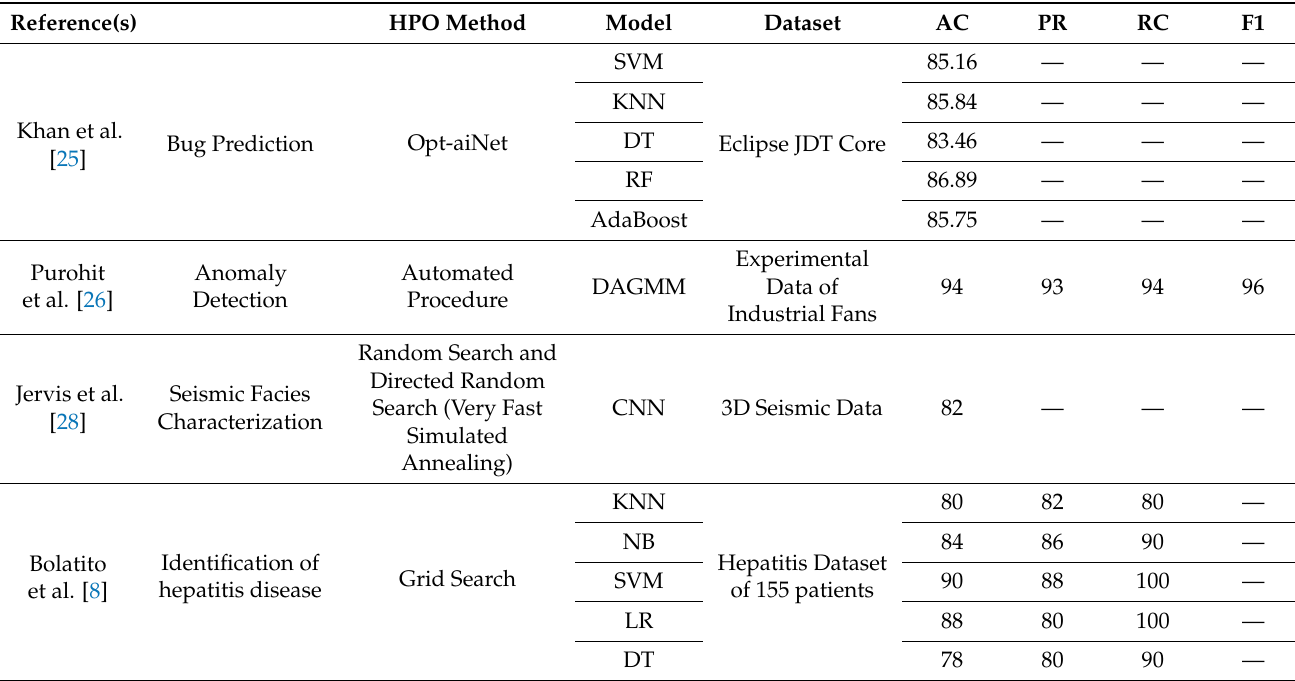
Table Legend: DT: Decision Tree; RF: Random Forest; SVM: Support Vector Machine; KNN: K-Nearest Neighbors; NB: Naive Bayes; DAGMM: Deep Auto-Encoder Gaussian Mixture Model; CNN: Convolutional Neural Network; LR: Logistic